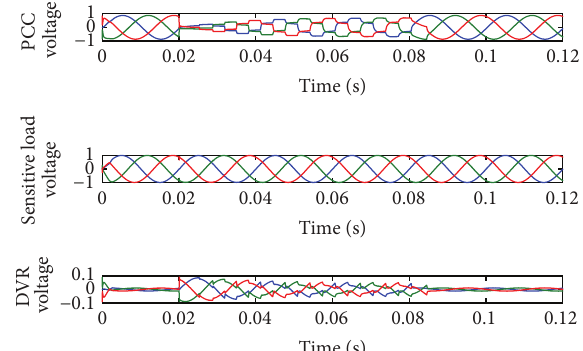
Figure 5: Performance of DVR with nonlinear load using AGPSO1 based PI